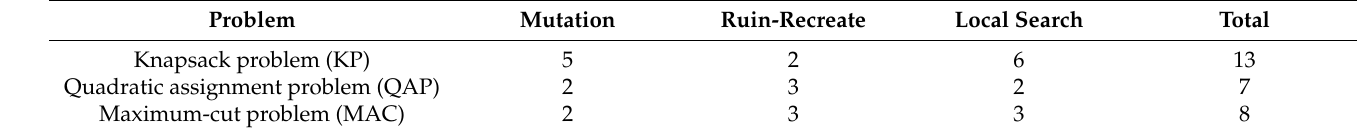
Table 1. Tally of the LLHs across the Knapsack, Maximum-Cut, and Quadratic Assignment Problems. Problem Mutation